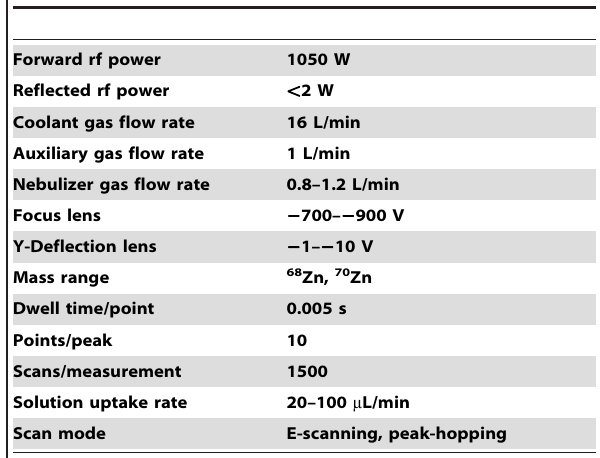
Table 1. Typical Element 2 ICP-MS Instrumental parameters for the determination of zinc isotope ratios.